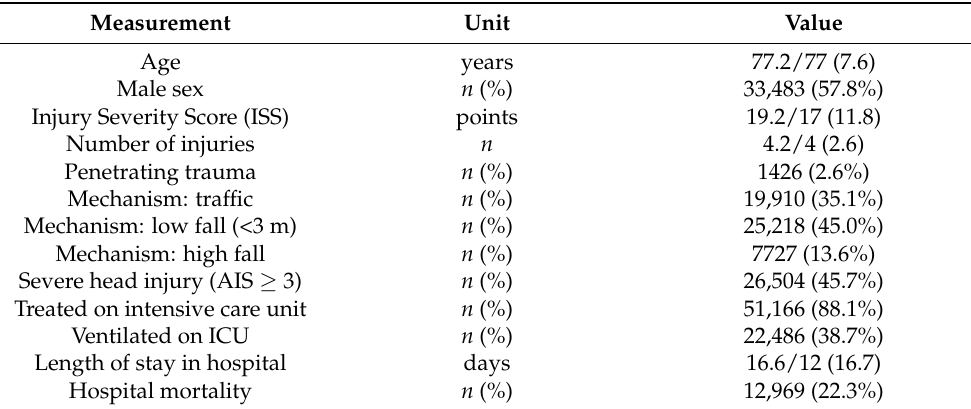
Figure 1. Inclusion flow of selected patients from the TraumaRegister DGU ® (TR-DGU). PRBC, Packed Red Blood Cells. Table 1. Basic data of 58,055 geriatric trauma patients.